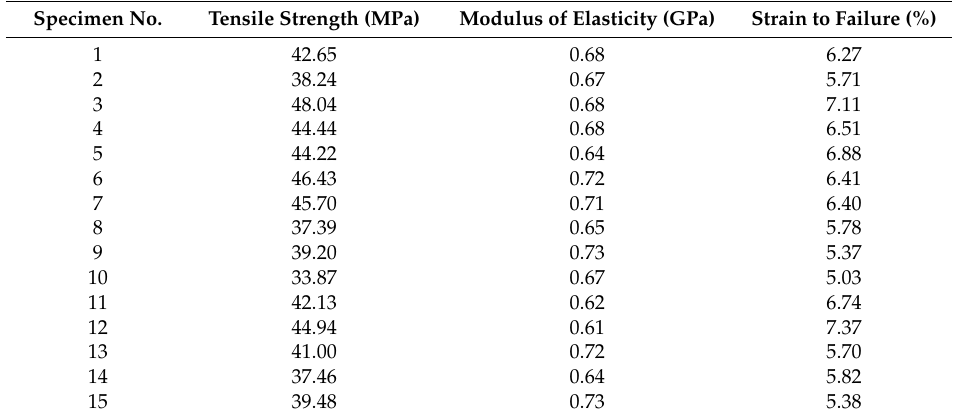
Table 1. Properties of jute yarn.